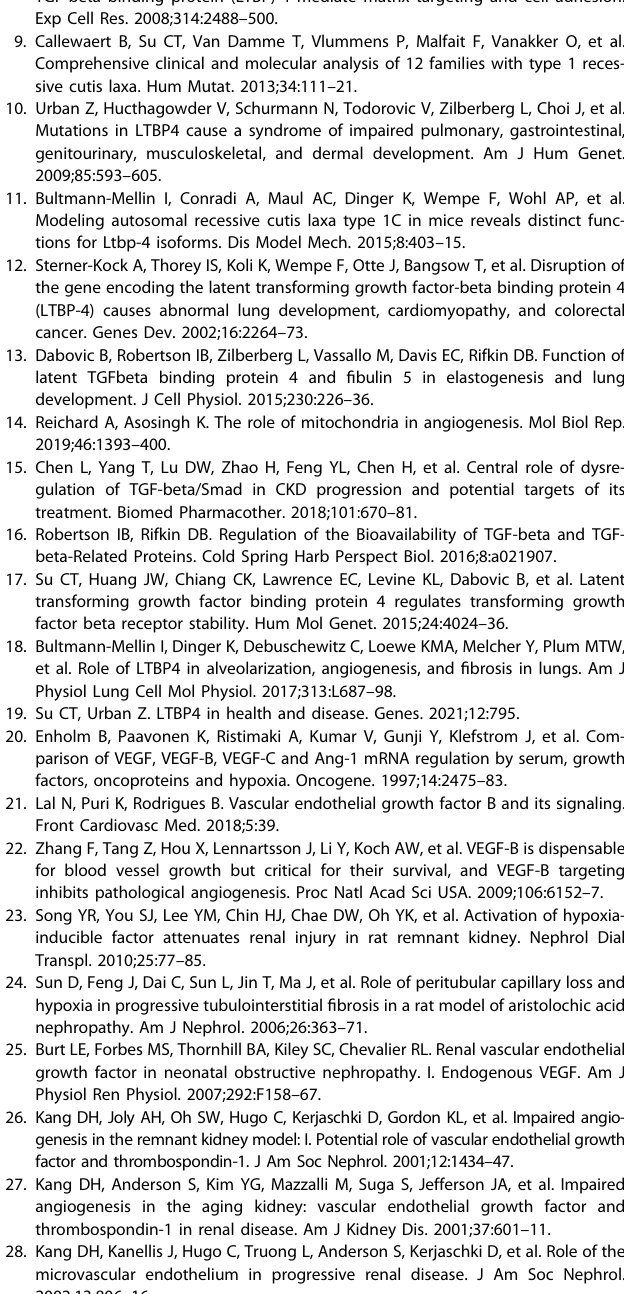
Fig. 6 LTBP4 preserves mitochondrial functions in response to hypoxia and Ltbp4 de fi ciency contributes to fragmented mitochondria and aggravates oxidative stress in mice with unilateral ureteral obstruction (UUO). Seahorse XF Cell Mito Stress Test performed on LTBP4- overexpression human proximal tubule cells cultured under hypoxic conditions (H) for 48 h (H/48 h). A OCR pro fi le plot, maximal respiration, ATP production and based glycolysis are higher in hypoxic LTBP4-overexpression cells (LTBP4) compared to hypoxic cells with normal LTBP4 expression (Mock). In vivo, tubulointerstitial fi brosis was induced by UUO for 5 days in wild-type (WT) and Ltbp4S knockout ( Ltbp4S − / − ) mice. These data were calculated from three independent experiments. Where indicated, O: oligomycin (1 μ M), F: FCCP (1 μ M) and R/A: rotenone/ antimycin A (0.5 μ M) were added. Each data point represents the mean ± SD. B Representative electron microscopic images of proximal tubular cells of the kidneys of WT and Ltbp4S − / − mice with UUO. White arrows indicate mitochondria. N indicates nuclei. Scale bars = 1 μ m. Computer-assisted quantitative analyses of electron microscopic images for mitochondrial length ( C ) and number ( D ) are shown. E , F Assessment of reactive oxygen species by immunohistochemistry staining for 4-HNE in kidney sections. The kidney sections of Ltbp4S − / − mice with UUO showed strong positive staining for 4-HNE. Scale Bar = 100 μ m. Data are presented as the mean ± SEM for each group of mice ( n = 4 – 6 per group). * p < 0.05. 4-HNE: 4-hydroxynonenal. Results are from three independent experiments.